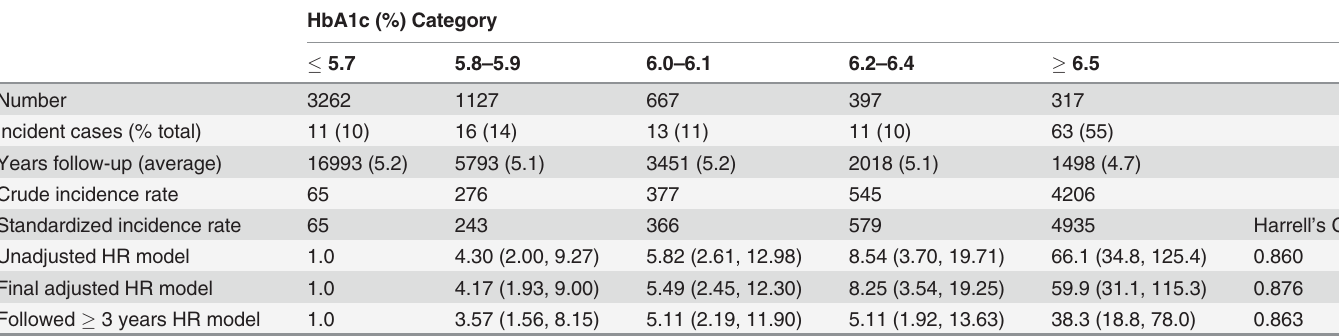
Table 2. Incidence rates and hazard ratios (HR) with 95% con fi dence intervals for incident type 2 diabetes according to category of glycated hemoglobin (HbA1c%), The Singapore Chinese Health Study. HbA1c (%) Category (cid:1) 5.7